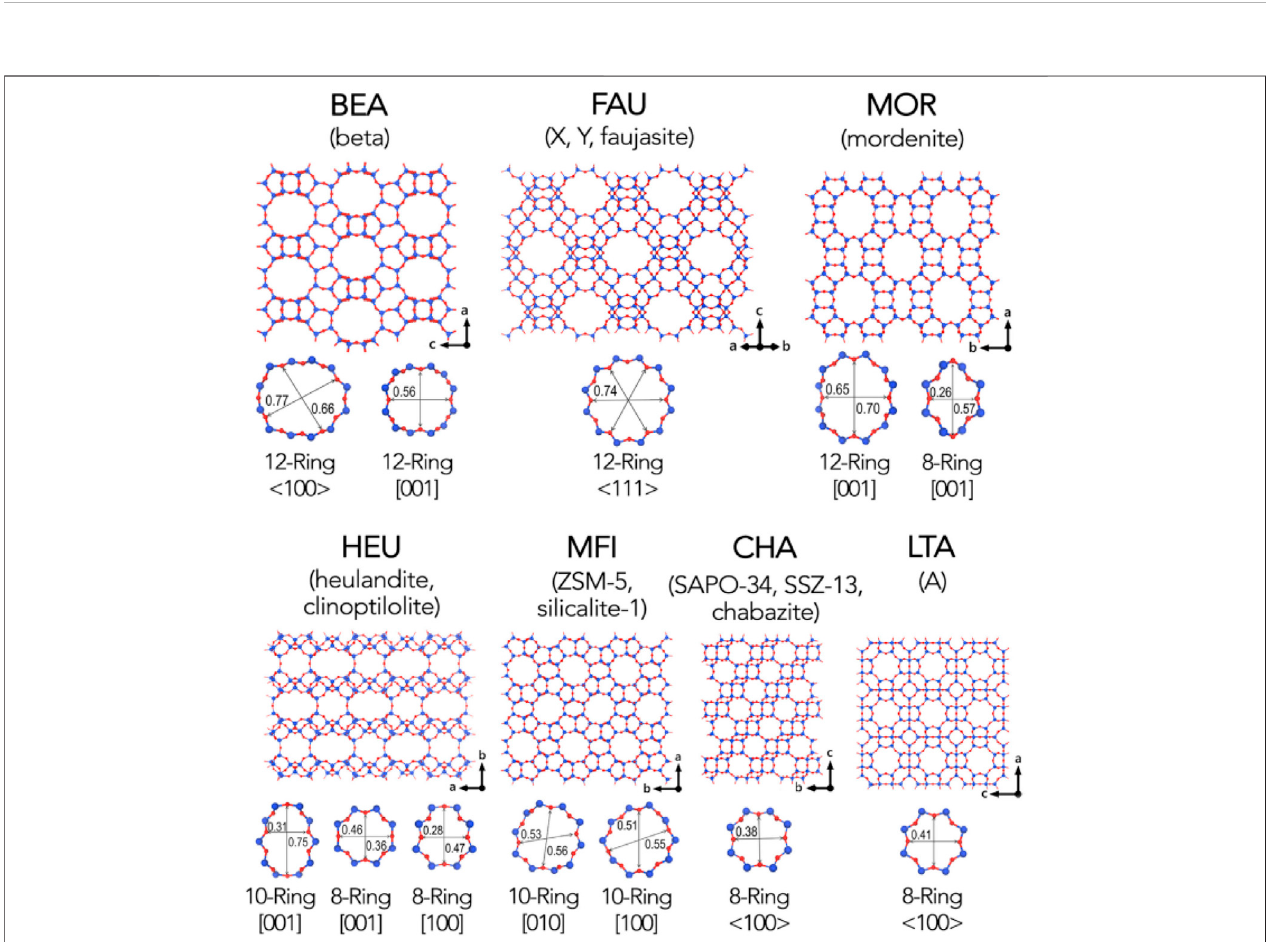
FIGURE 3 | Common framework types of zeolite molecular sieve (Li et al., 2017). The blue sphere represents the T atom, and the red sphere represents the oxygen atom.